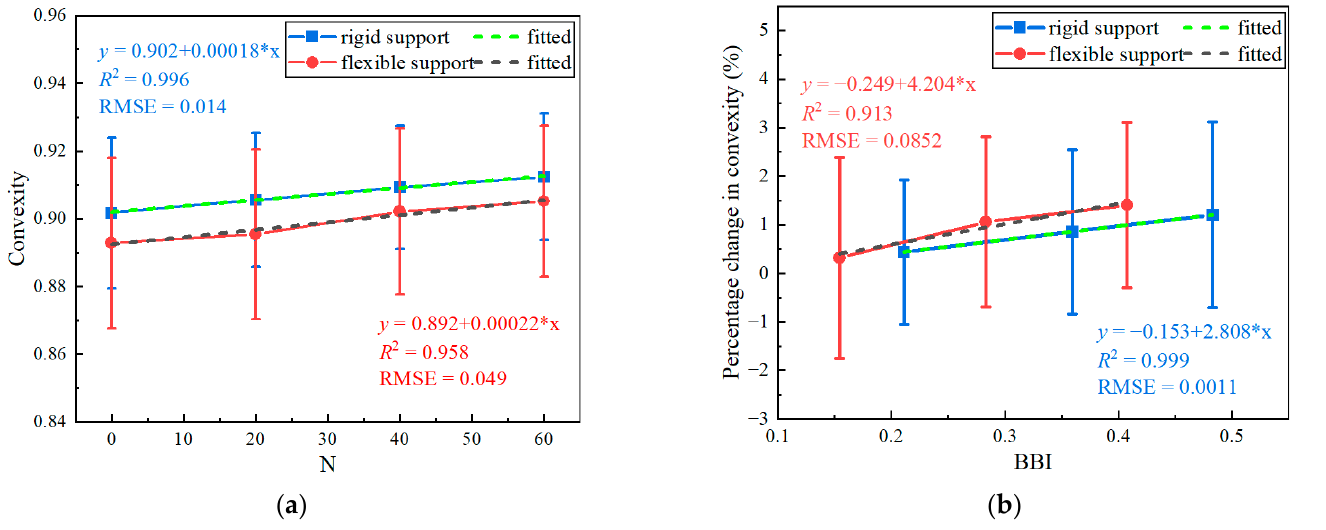
Figure 17. The evolution of ( a ) convexity index with the number of impact-load applications (N), and ( b ) the statistical correlation of the breakage index (BBI) with the convexity index for multiple-size ballasts over rigid and flexible supports.